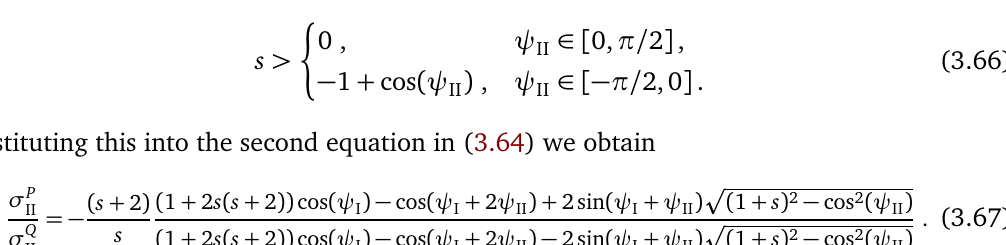
Figure 7: The solutions s ∗ For Θ large enough there are always two geodesics that connects them of the kind of figure